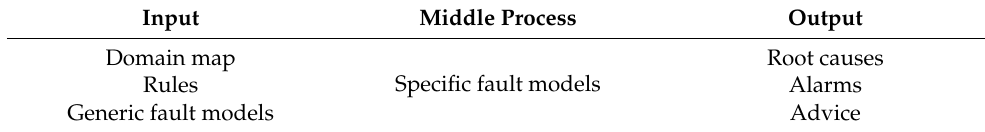
Table 10. The input and output of expert system